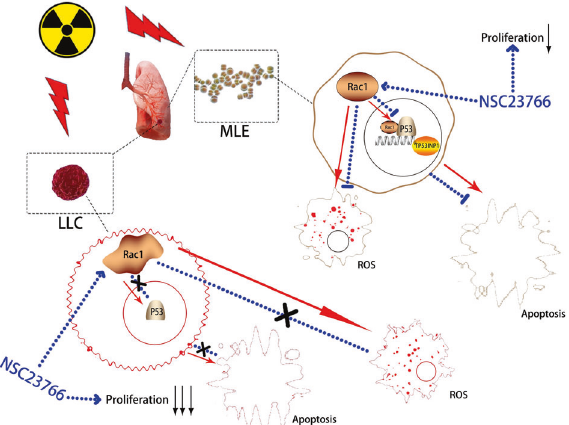
Fig. 8 Summary of study. Ionizing radiation induces the nuclear translocation of Rac1, the latter then binds with p53 and prolongs the residence time of p53 in the nucleus, thereby promoting the transcription of Trp53inp1 which mediates p53-dependent apopto- sis. Inhibition of Rac1 with NSC23766 could reduce the nuclear translocation of Rac1 induced by irradiation, thereby fasting the release of p53 from the nucleus, at last reducing the apoptosis. In addition, Rac1 inhibition could also signi fi cantly reduce ROS generation, but have no effect on the proliferation of MLE. In contrast, due to the overexpression and mutation of Rac1, inhibition of Rac1 does not reduce the apoptosis of tumor cells after radiation but can inhibit the proliferation ability of tumor cells signi fi